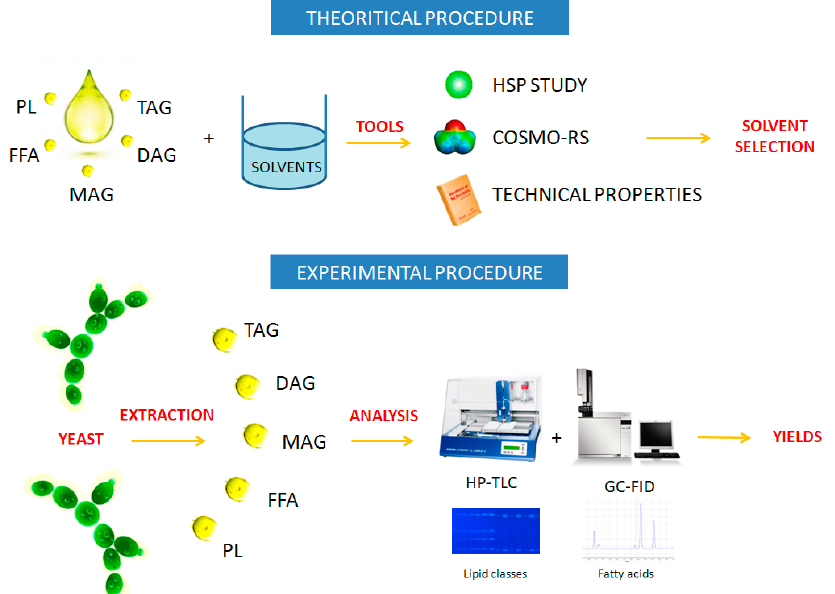
Figure 1. The aim is to compare both scientific approaches (theoretical procedure vs . experimental procedure) and to show the global procedure. procedure) and to show the global